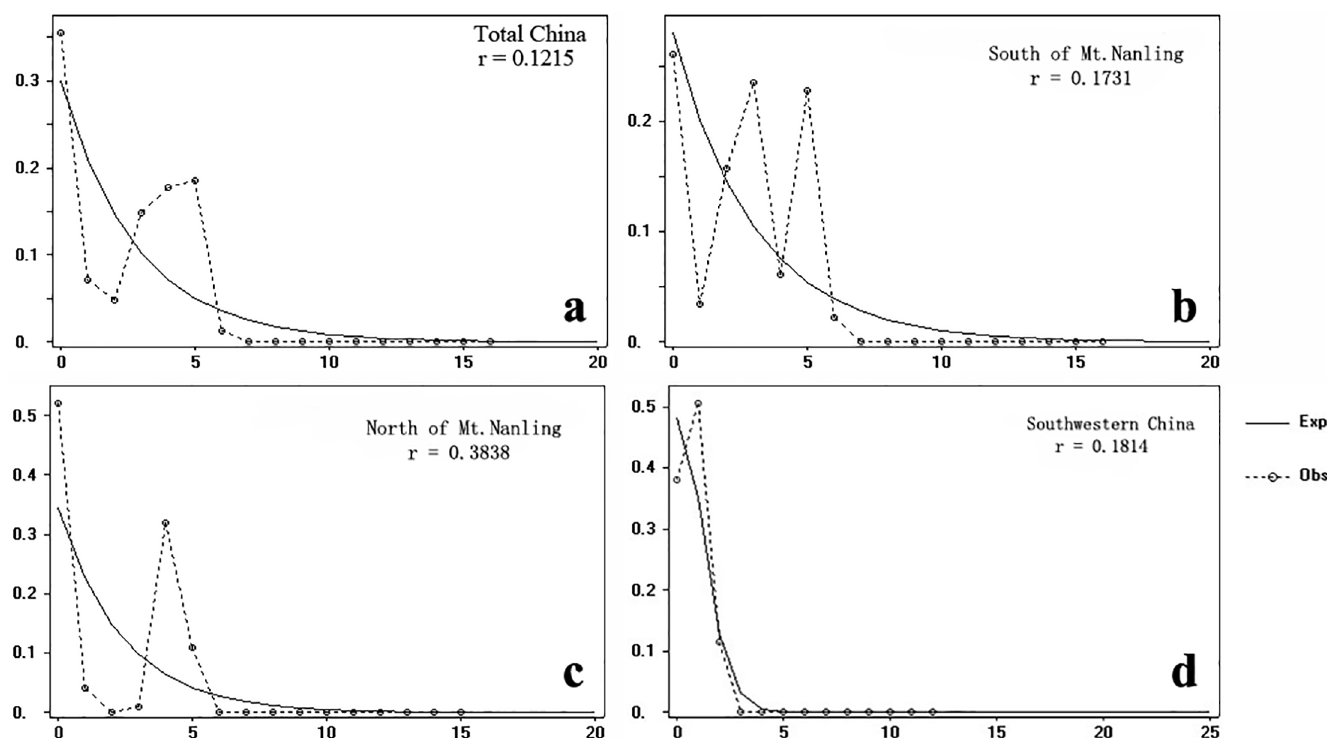
Fig 3. Mismatch distribution analysis of Bretschneidera sinensis among different biogeogrphical groups. (A) Total China. (B) South of Mt. Nanling.(C) North of Mt. Nanling.(D) Southwestern China.